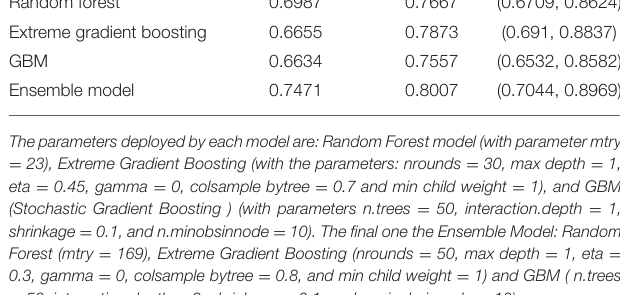
TABLE 5 | Importance of the variable scaled according the method varImp in the caret library for the complete data set. Important